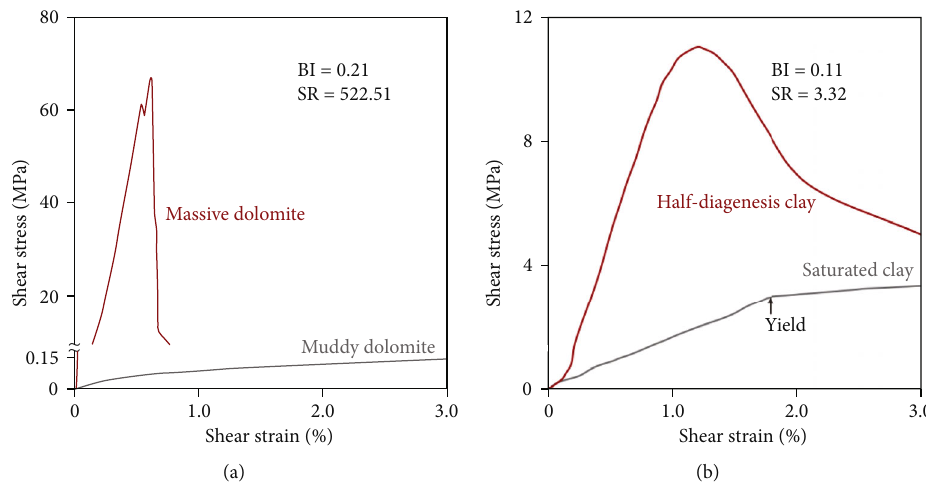
Figure 3: Shear stress − strain relations of the strain-softening strong media constituting locked segments (red curves) and strain-hardening weak media fi lling the lower trans fi xion segments (gray curves) on the slip surfaces of the (a) Yanchihe [21] and (b) Longxi slopes [8]. BI denotes the brittleness index [22] of the strong media (where a greater BI indicates a higher brittleness), and SR denotes the shear strength ratio of strong medium to weak